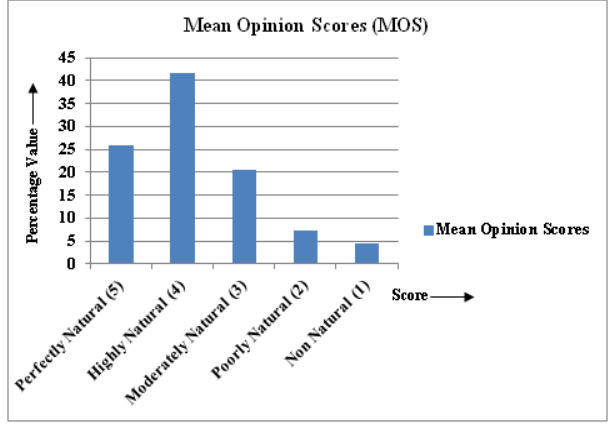
Figure 11. Plot of MOS for subjective image color quality